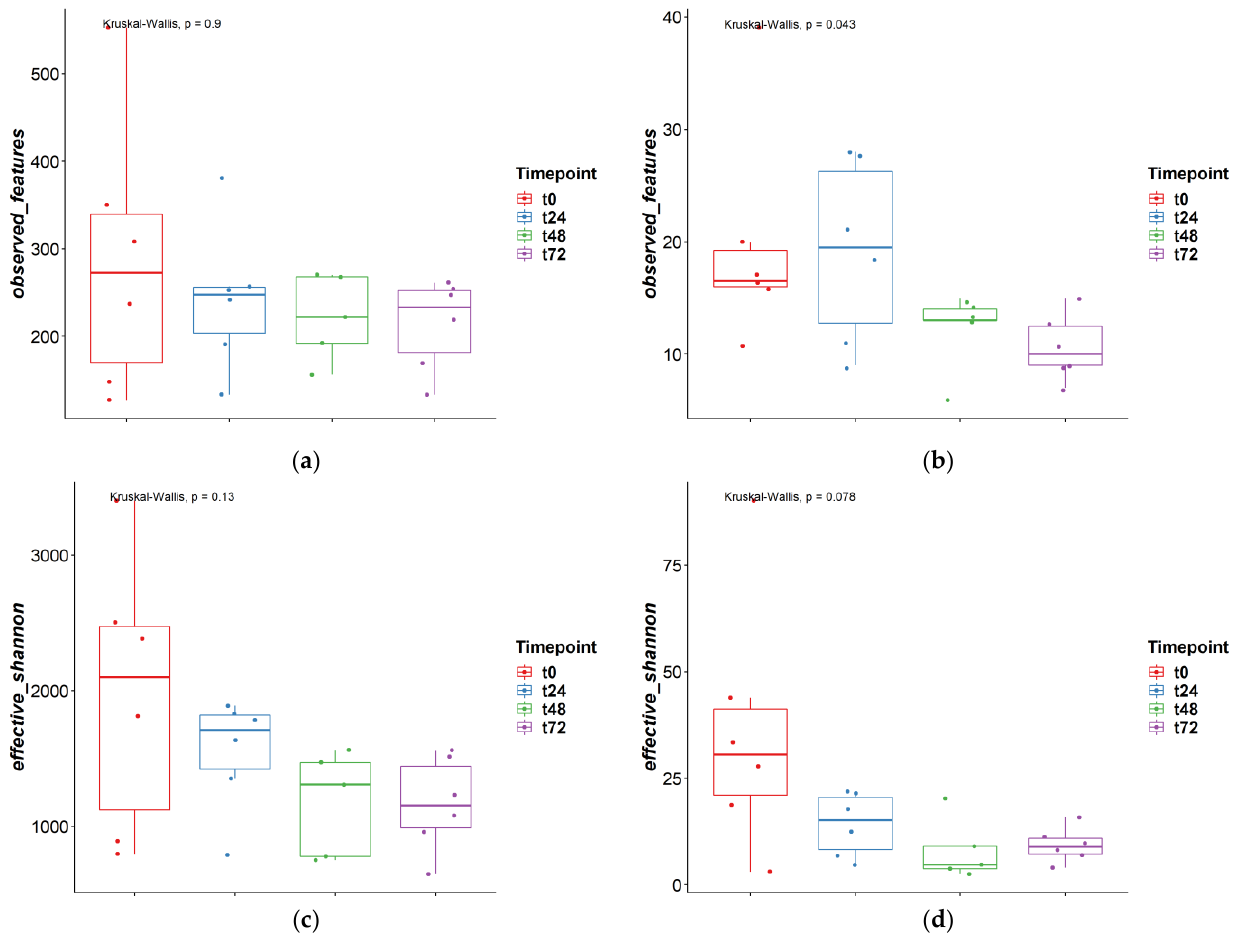
Figure 1. Alpha diversity measures different time points ‘observed features’ and ‘effective Shannon’; ( a ) and ( c ) = bacteria, ( b ) and ( d ) = fungi.